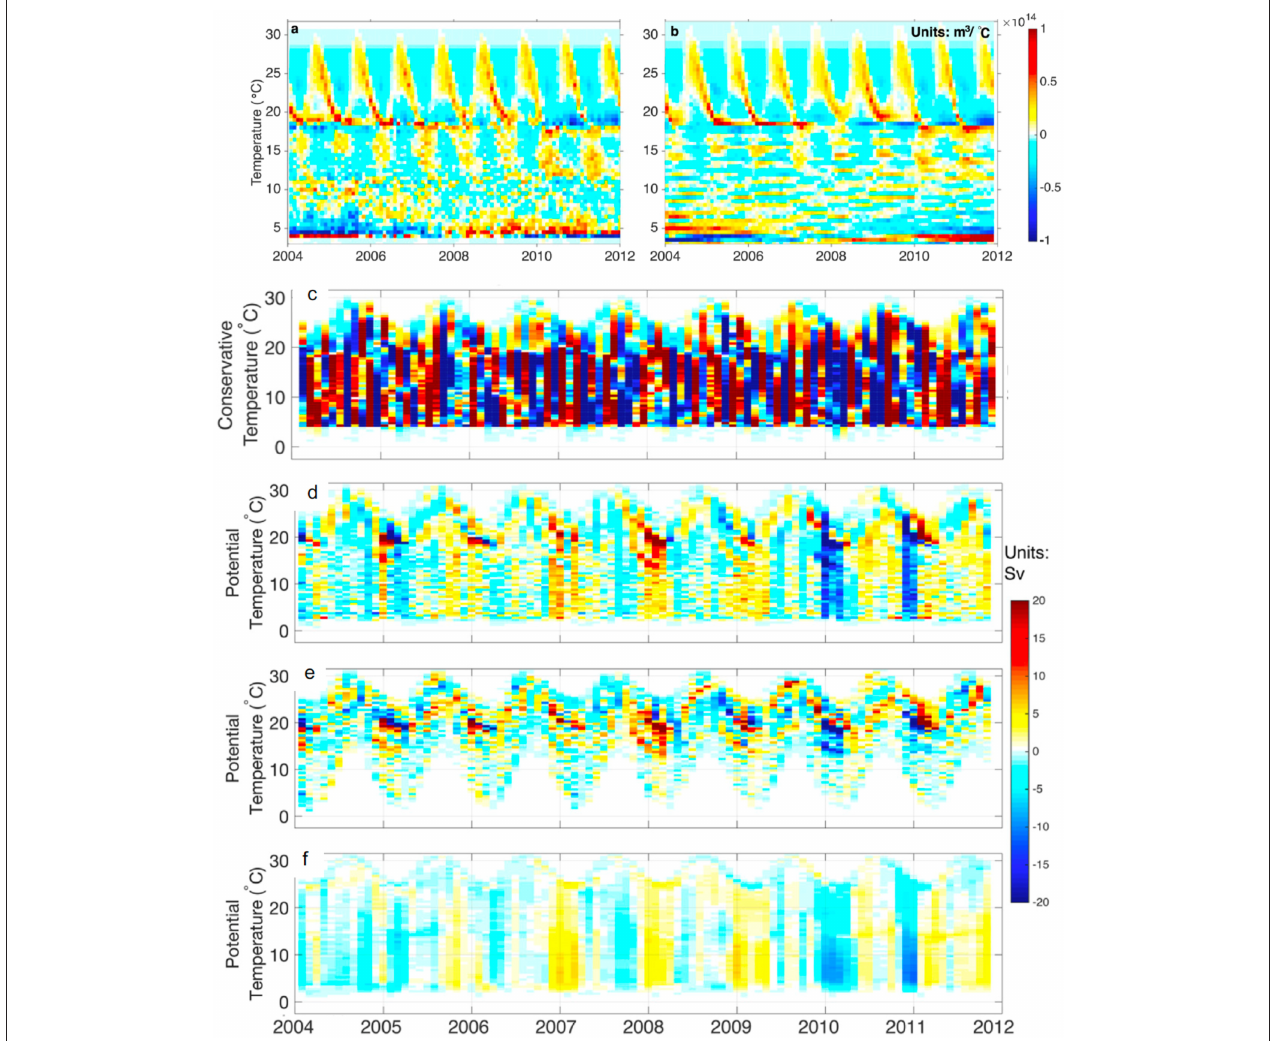
FIGURE 2 | Top panels: Volume anomaly in temperature classes, V ( θ , t ), with respect to the time mean in the North Atlantic between 26 and 45 N from (a) RGAC and (b) ECCOv4. Lower panels: Total monthly d V / d t between 26 and 45 N from (c) RGAC and (d) ECCOv4. Also shown in (e) is the diabatic contribution to (d) inferred from monthly diathermal transformation due to air-sea heat fluxes, and (f) the adiabatic transformation in (d) implied by the volume change per temperature class due transport divergence between 26 and 45 N. For details, see Evans et al. (2017). © American Meteorological Society. Used with permission.